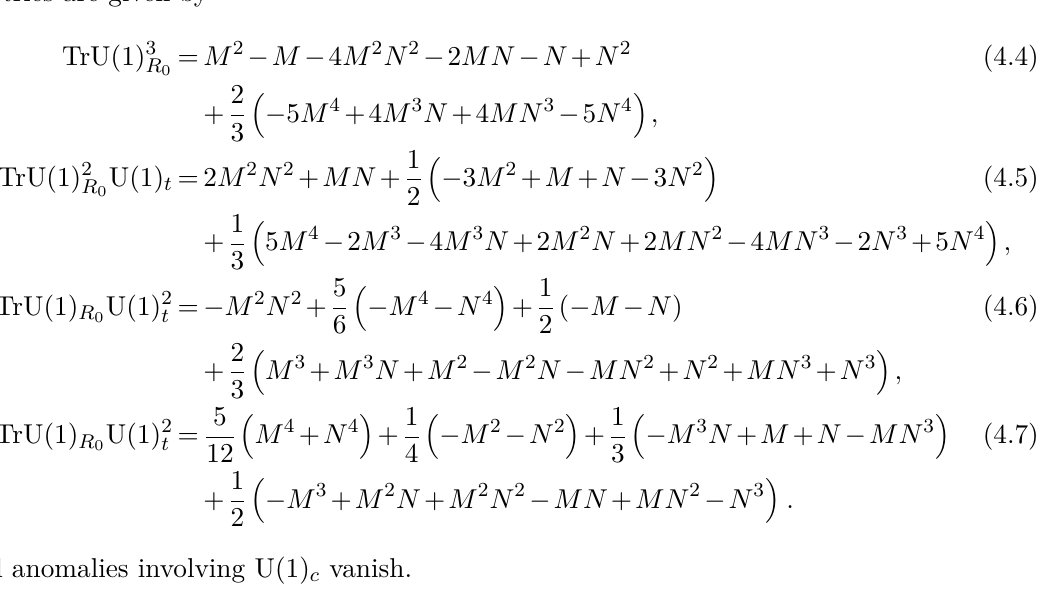
metries are given